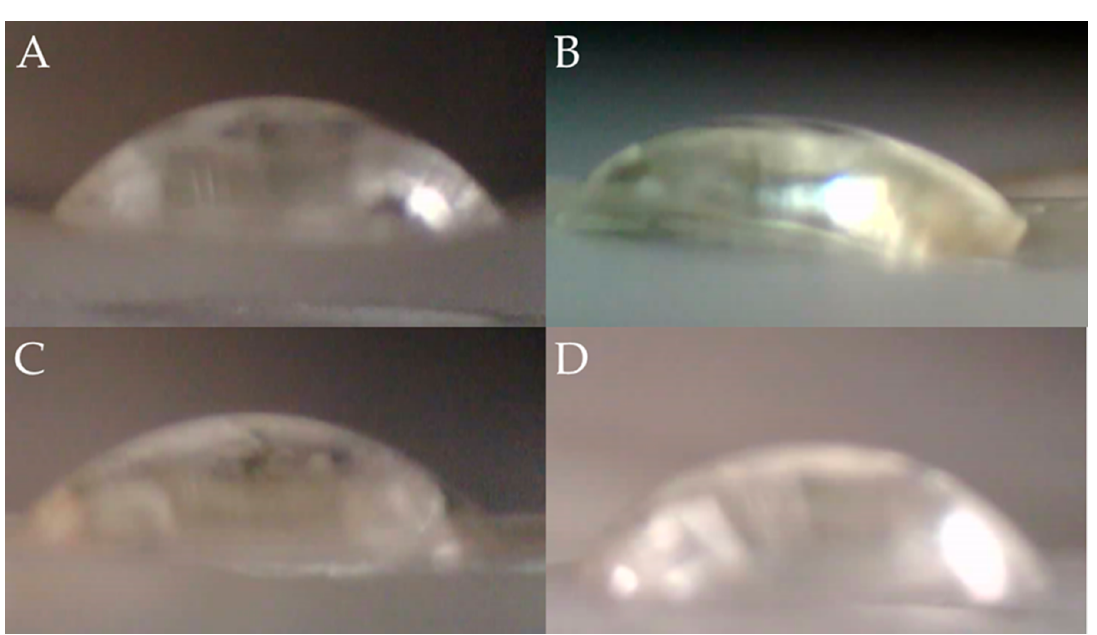
Figure 4. Images for contact angle measurements. ( A ) PVA/CHI/ADD/AMP 0.3% (ethylene glycol) ( B ) PVA/CHI/ADD/AMP 0.3% (diiodomethane) ( C ) PVA/CHI/ADD/AMP 1.0% (ethylene glycol) ( D